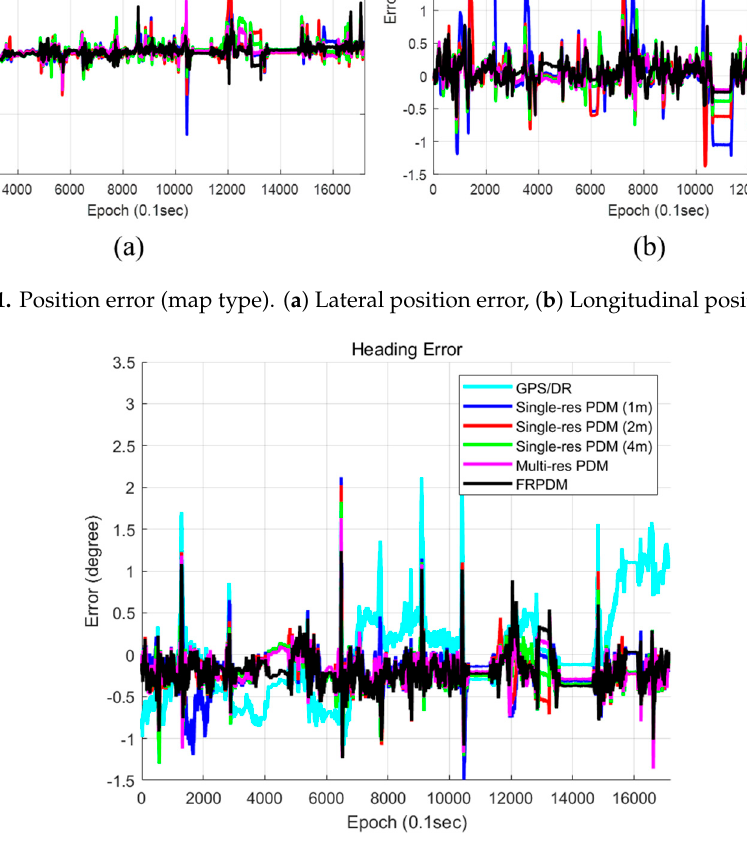
Figure 33. GPS/DR increment error. Table 3. Comparison of localization performances (map type).